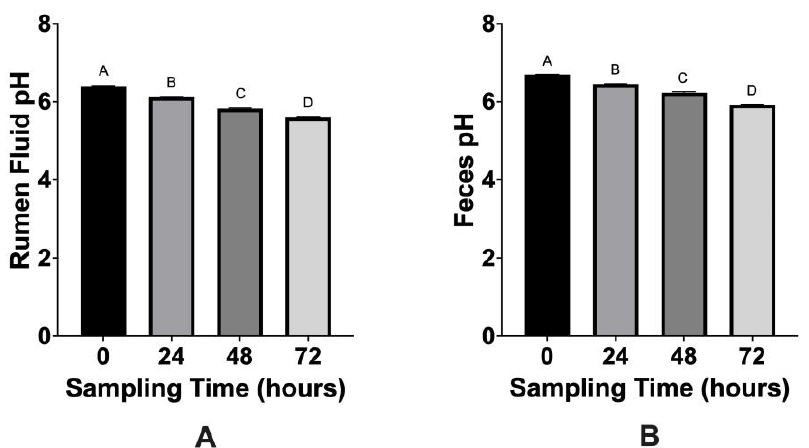
Figure 2. ( A , B ). Mean pH of cattle ruminal fluid ( A ) and cattle feces ( B ) at 0, 24, 48, and 72 h following treatment with varying concentrations of Megasphaera elsdenii as an in vitro model. Error bars represent standard error of the mean. Sampling points with different superscripts are statistically different ( p ≤ 0.05).